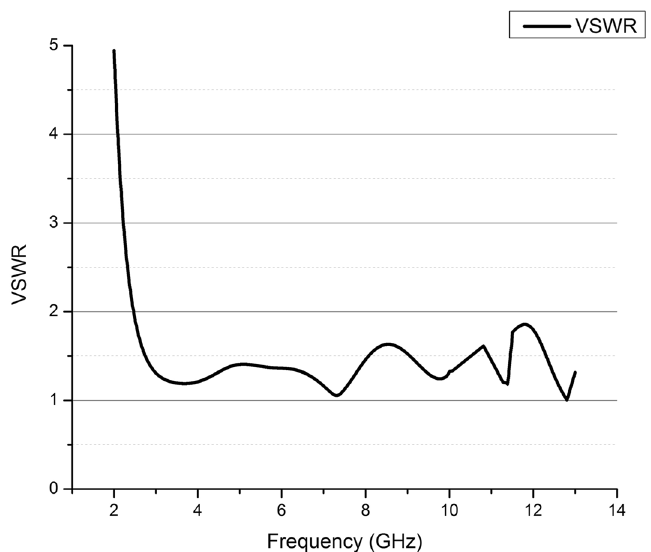
Fig. 6 VSWR variation over UWB range